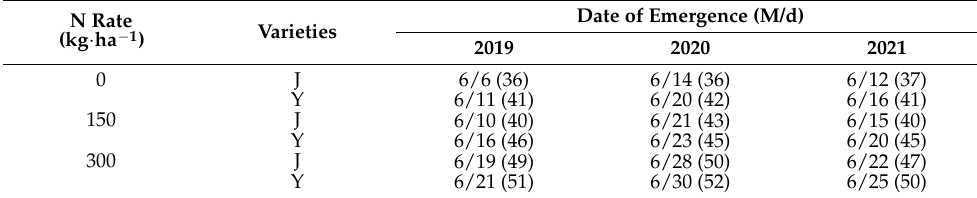
Table 6. Emergence dates of two potato varieties at different nitrogen application